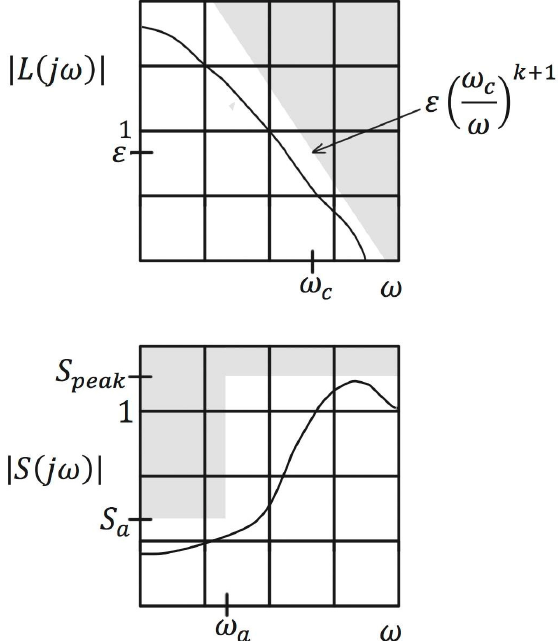
Figure 2. Loop gain and sensitivity constraints (Equations (9) and (10)) for performance limitations analysis.